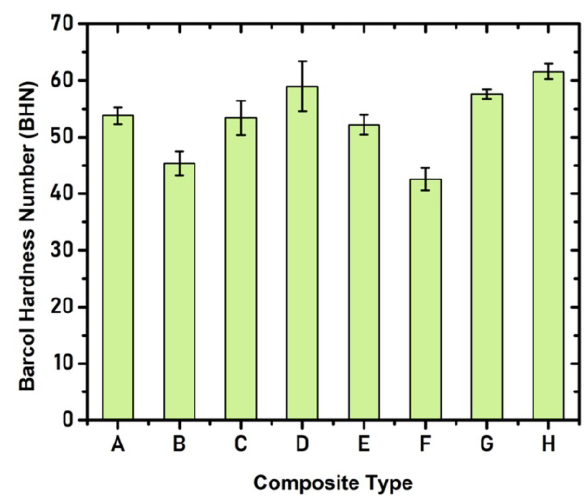
Figure 3. Barcol Hardness of different composites.